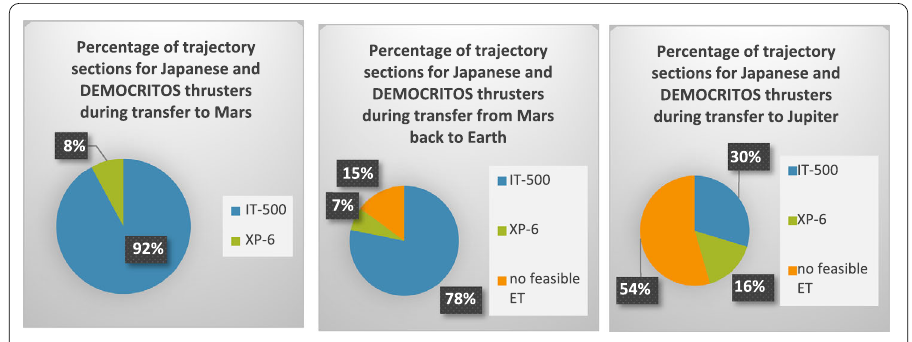
Figure 10 Percentages of trajectory sections for the cluster of Japanese and DEMOCRITOS thrusters